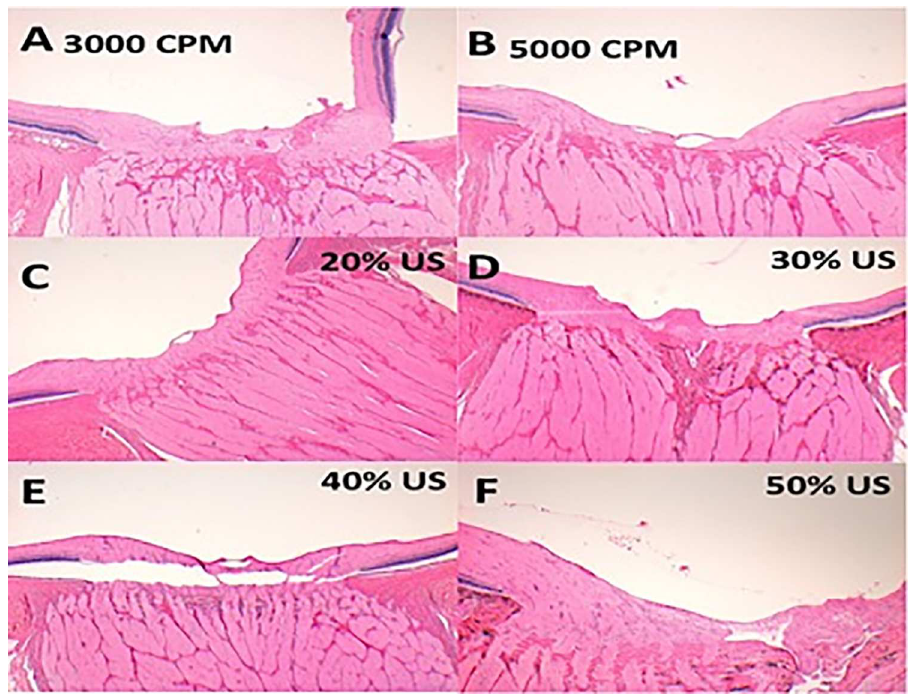
Fig 4. Hematoxylin-eosin stained sections through the optic nerve head from porcine cadavericeyes after PPV. (A and B), Sections from eyes that underwent pars plana vitrectomy using the guillotinecutter at 3000 cuts per minute (A) or 5000 cuts per minute (B). (C, D, E and F), Sections from eyes that underwent pars plana vitrectomy using the hypersonicvitrector set at 20% (C), 30% (D), 40% (E), and 50% (F) ultrasound power. (A) and (F) show a subhyaloid haemorrhage and retinal detachment. E shows presumedartifactual detachment. (A, C, D and E) Sections from a open-skyvitrectomy procedures.(B and F) Sections from a closed vitrectomy